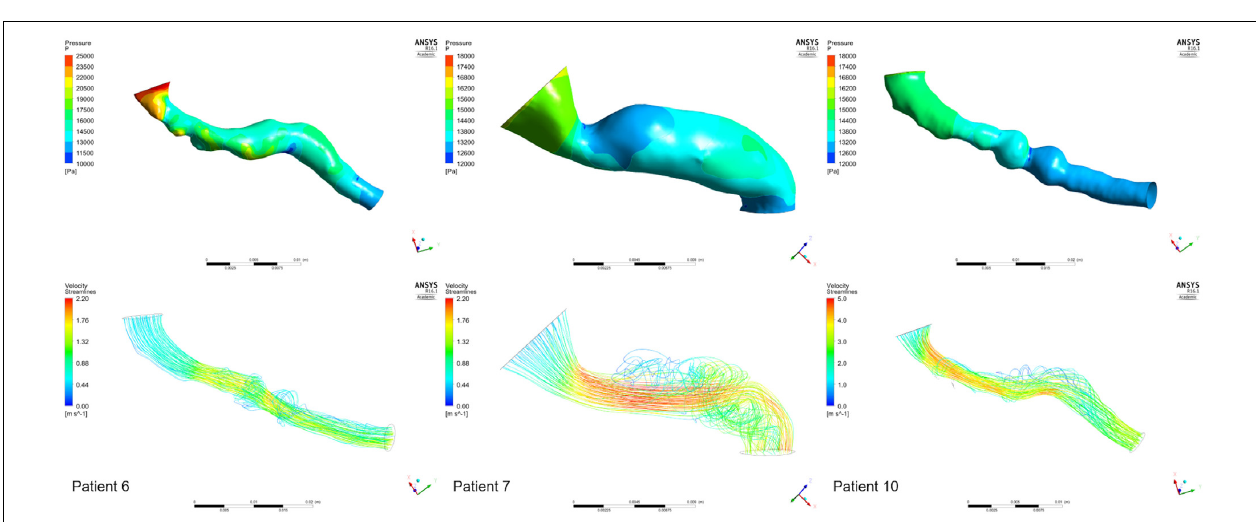
Frontiers in Physiology |